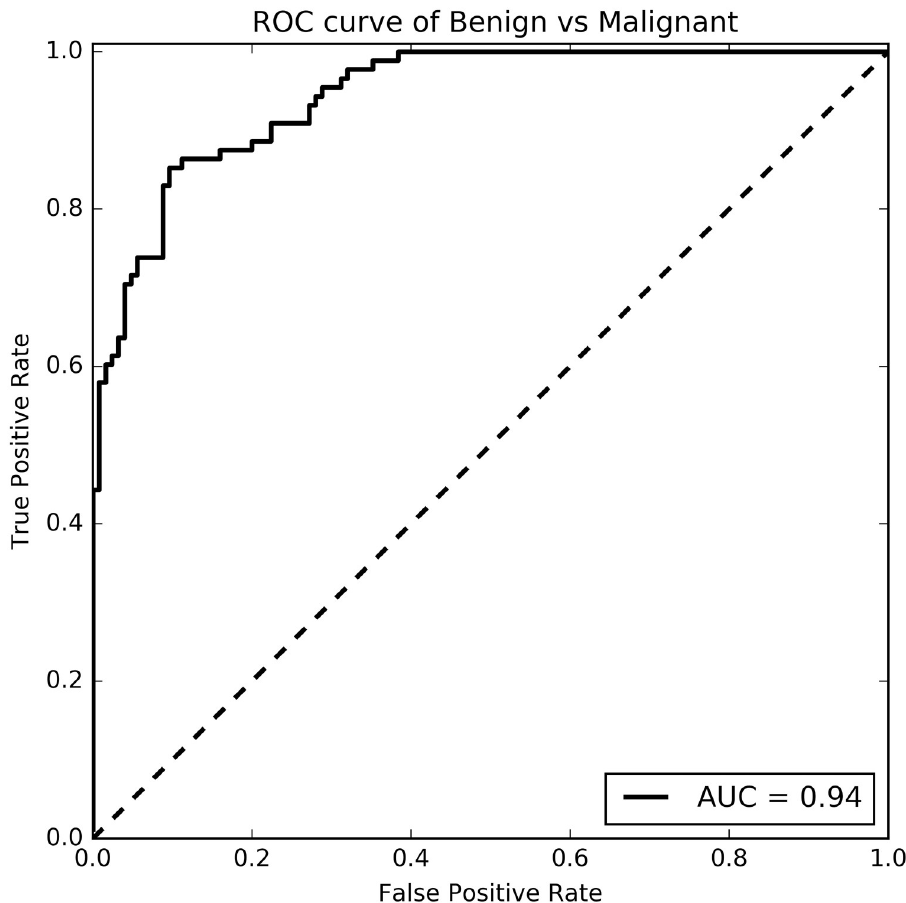
Fig 4. ROC curve of benign-versus-malignant classification problem. The area under the ROC curve (AUC) is 0.94.